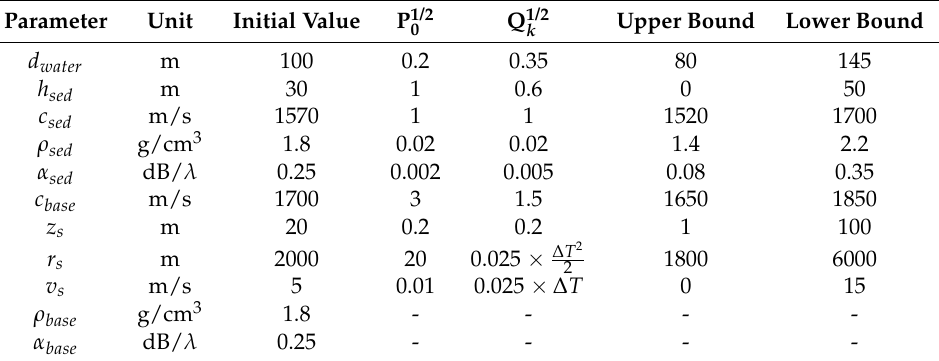
Table 1. The environment parameters in the